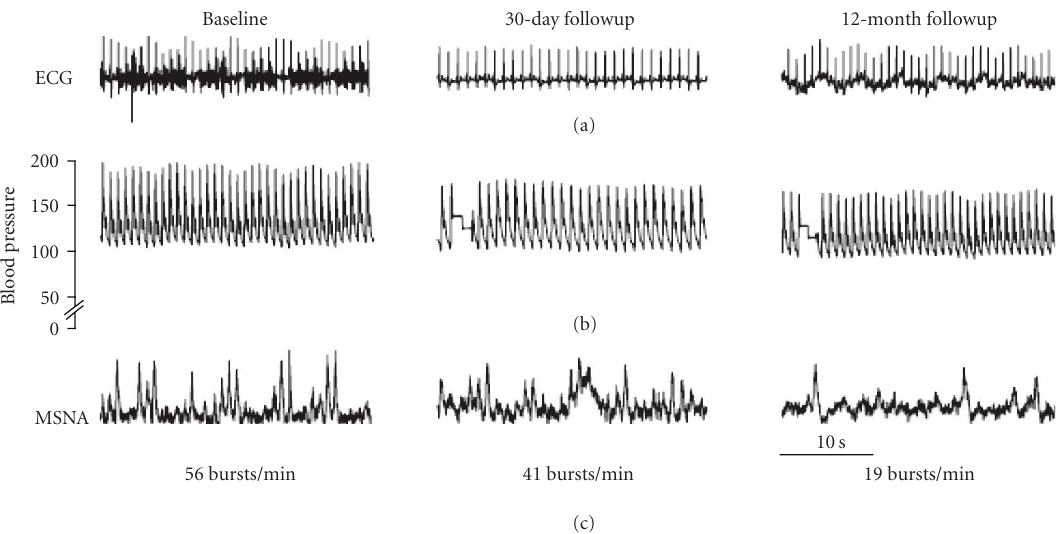
Figure 9: Results of microneurography before and after renal nerve ablation. Panel (a) shows the results of bilateral renal denervation, as assessed by the radiotracer dilution method, at baseline and 30 days after the procedure. After ablation, decreases in renal norepinephrine spillover were observed in both kidneys (48% in the left kidney and 75% in the right kidney), indicating substantial modulation of renal sympathetic e ff erent nerve activity after the procedure. Simultaneously, a marked reduction in whole-body sympathetic nerve activity was apparent, with a decrease in whole-body norepinephrine spillover of 42% (b). Panel (c) shows a reduction in muscle sympathetic-nerve activity (MSNA), as assessed in the peroneal nerve on microneurography, after bilateral renal nerve ablation, which highlights the possibility that inhibition of a ff erent renal-nerve activity may contribute to the reduction in central sympathetic